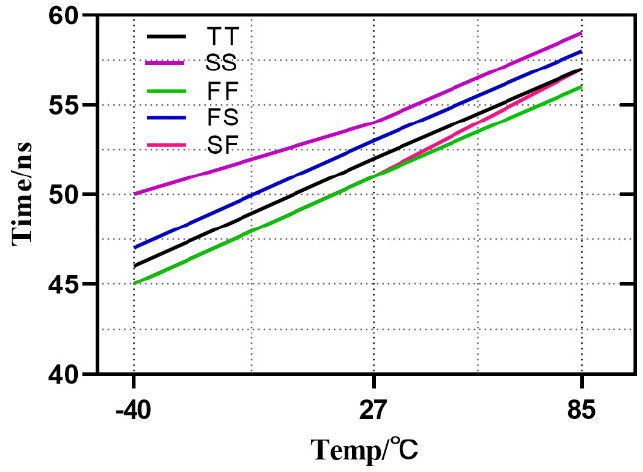
Figure 12. Recovery time versus process corners and temperature variations. Figures 13 and 14 present the simulated overshoot and undershoot against process corners and temperature variations ( − 40 ◦ C, 27 ◦ C and 85 ◦ C). The max overshoot was 283 mV at 85 ◦ C in the SS corner, while the min overshoot was 217 mV at − 40 ◦ C in the FS corner. The max undershoot was 280 mV at 85 ◦ C in the SS corner, and the min undershoot was 206 mV at − 40 ◦ C in the SS corner.